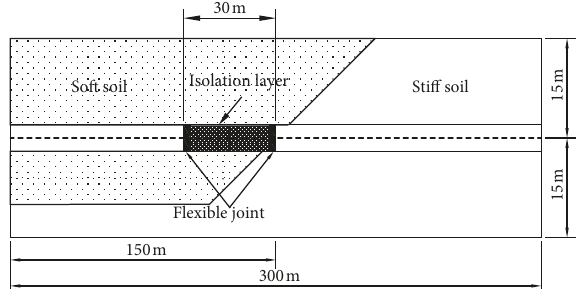
Figure 19: Shield isolation system for the shield